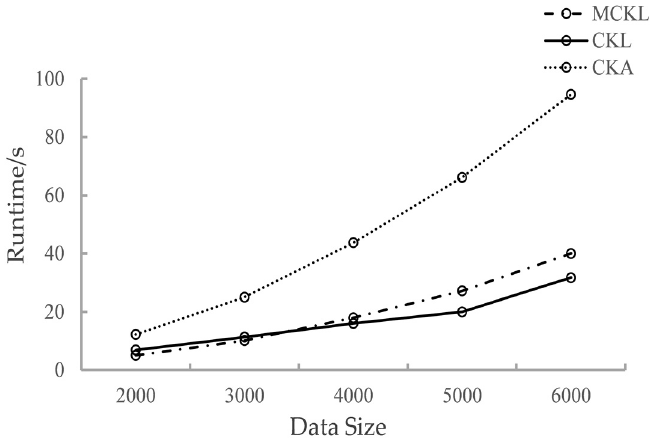
Figure 5. Effect of data size on Figure 5. E ff ect of data size on runtime.